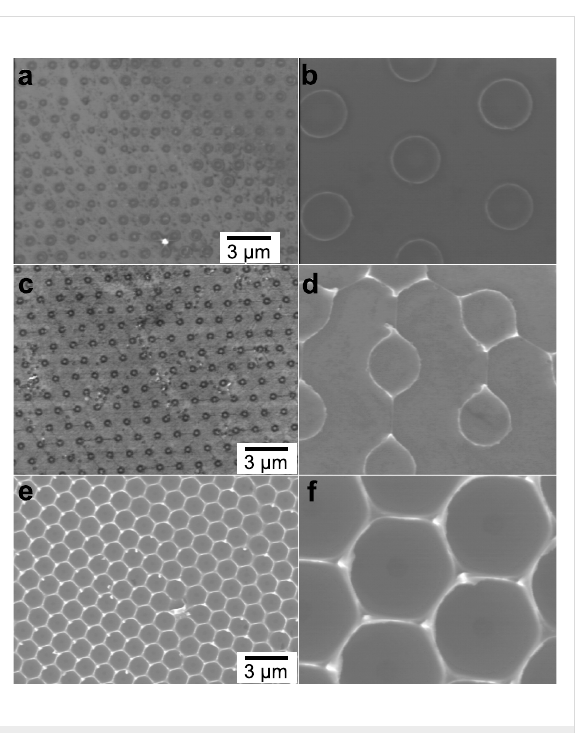
Figure 2: Low- (left column) and high-magnification (right column) SEM images of various TiO 2 seed patterns created after deposition of TiO 2 precursor for 10 s (a, b), 20 s (c, d), and 60 s (e,